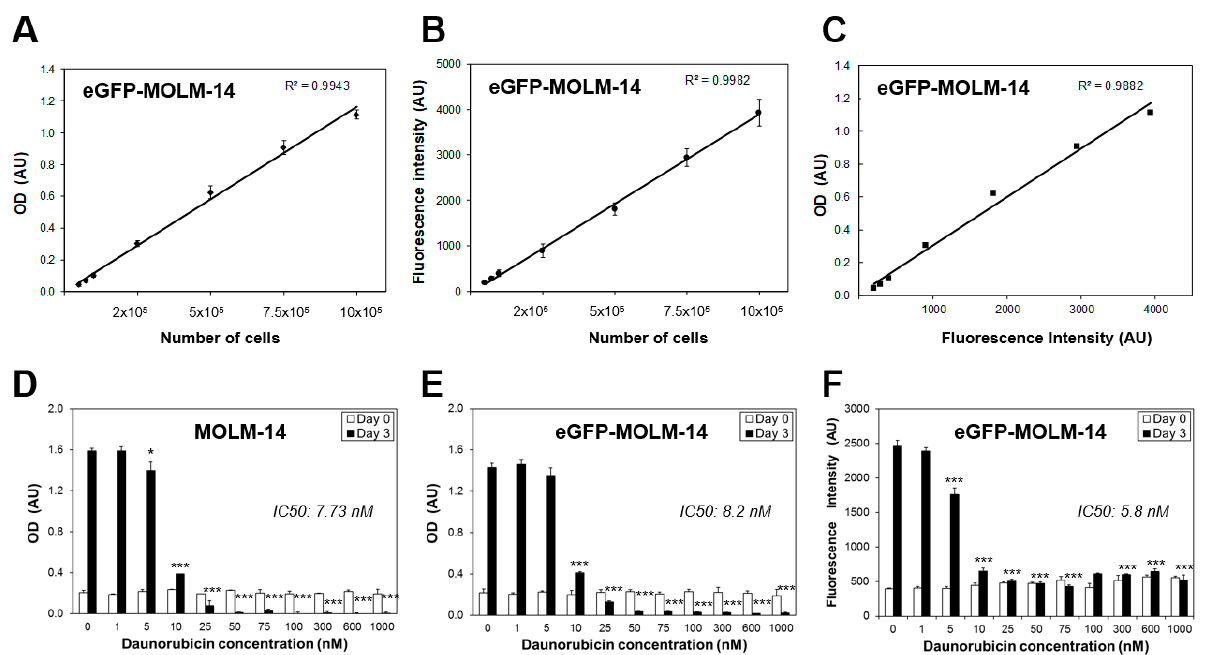
Figure 1. Characterization of eGFP-expressing AML cells. Comparison of the sensitivity of estimation of cell numbers by measuring optical density (OD) using an MTT assay in arbitrary units (AU), or fluorescent intensity emitted by eGFP-expressing tumour cells. Correlation between values of cell numbers seeded per well and OD ( A ) or fluorescent intensity ( B ). Correlation of values of OD and fluorescent intensity ( C ). Proliferation of parental ( D ) and eGFP-expressing MOLM-14 cells ( E ) left untreated or treated with increasing concentrations of daunorubicin was estimated using MTT assays or fluorimetry ( F ). The half maximal inhibitory concentration (IC50) values for inhibition of the proliferation of the cell lines are shown in the graphs. Plates used for measurements of optical density were previously used to measure fluorescent intensity of the cultures of eGFP-MOLM-14. * p < 0.05; *** p < 0.005 ANOVA test versus control untreated.